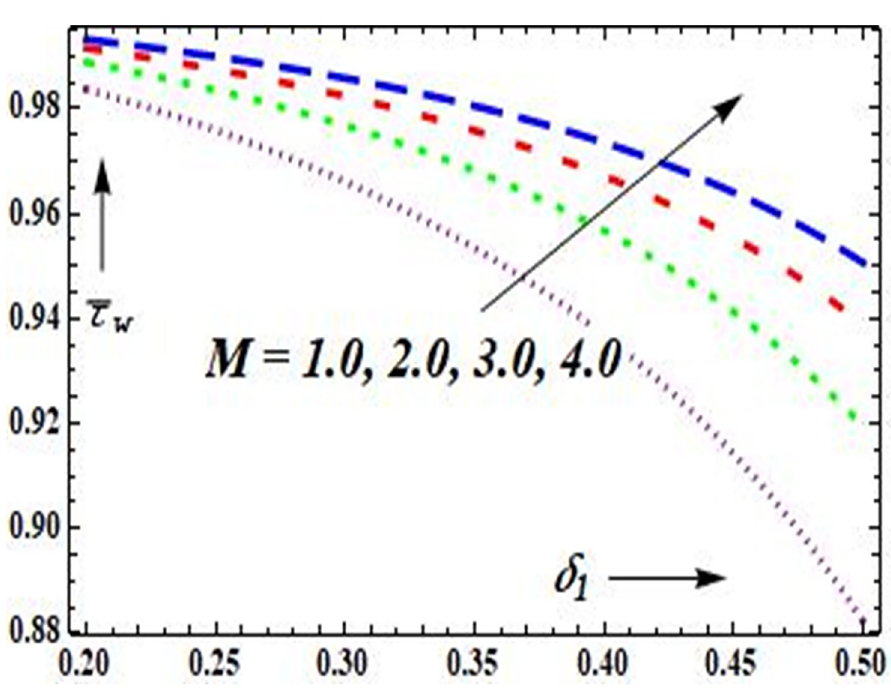
Fig 12. Plot of � τ